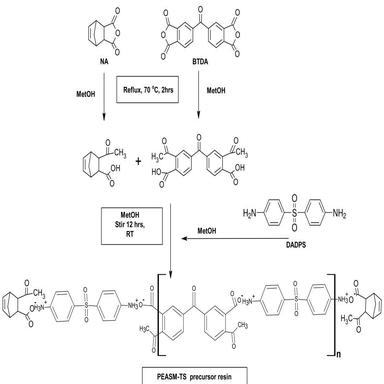
The synthesis scheme of the PEASM-TS precursor resin.